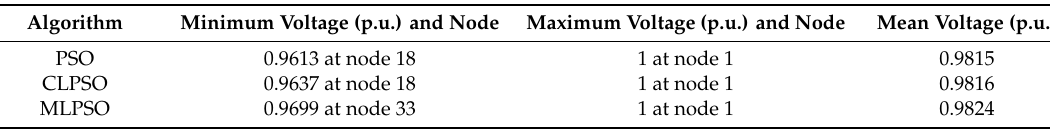
Table 4. Variation of voltages in PSO, CLPSO, and MLPSO algorithms for three DG scenario—IEEE 33 bus system.